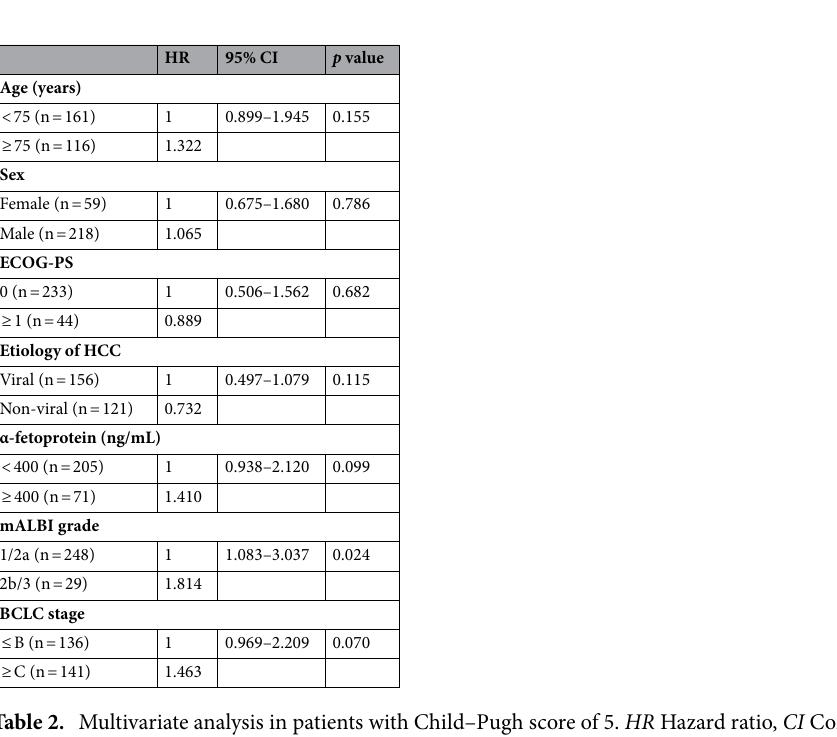
Table 2. Multivariate analysis in patients with Child–Pugh score of 5. HR Hazard ratio, CI Confidence interval, ECOG-PS Eastern Cooperative Oncology Group performance status, HCC Hepatocellular carcinoma, mALBI Modified albumin–bilirubin, BCLC Barcelona clinic liver